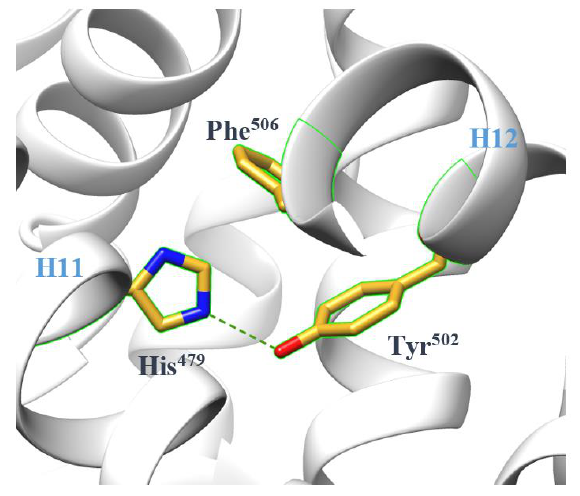
Figure 2. The agonist lock stabilizes H12 through a hydrogen bond (green dashed line) in the agonist-bound RORγ LBD (PDB 4S14).